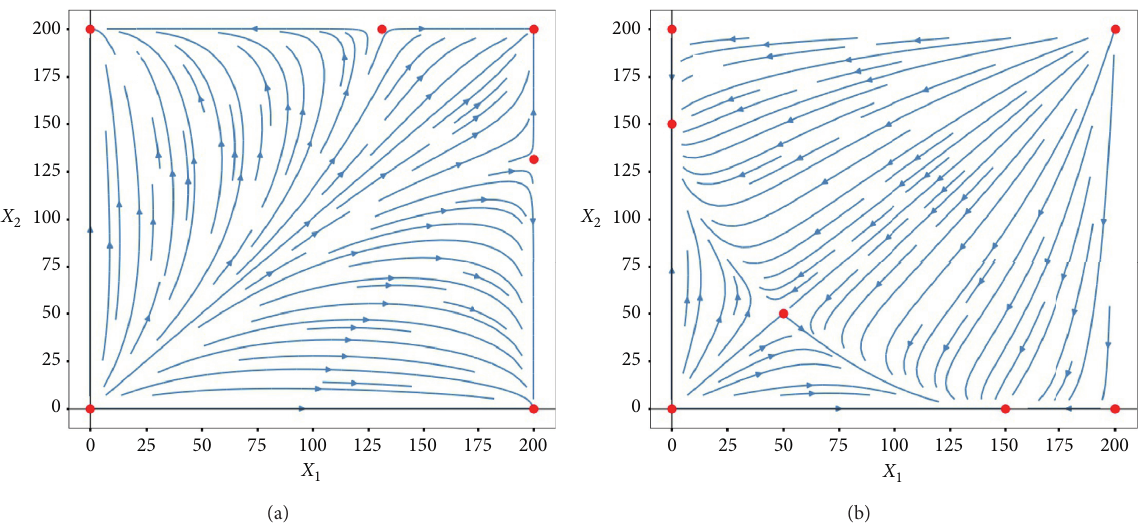
Figure 7: Phase space and trajectories for two populations involved in competition with positive intraspecific interaction. We used two � b � b � 0 . 0019, and we have the to see the influence of intraspecific cooperation and competition. (a) b different combinations of b 11 22 11 22 case in which both populations are cooperative and two new solutions appear together with a basin towards the carrying capacity of the � b � − 0 . 001, and we have the case in which both are competitive. Noting that when both populations are cooperative, system. (b) b 11 22 partial carrying capacities appear and they are both unstable. And when both populations are competitive, partial extinctions appear instead � r � 0 . 15 and b � b � − 0 . although stable and below the carrying capacities. Here, r 1 2 12 21